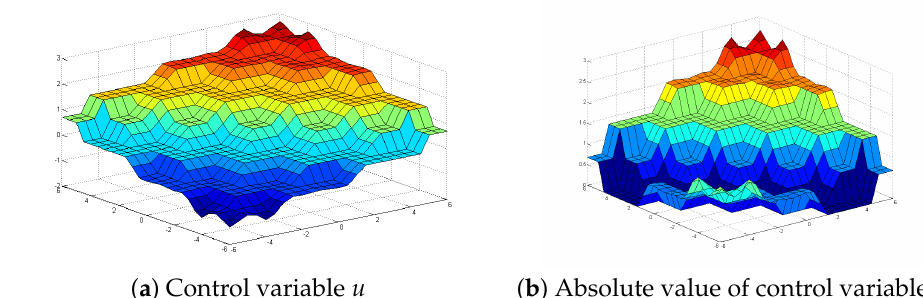
Figure 4. Inference results of the triple I algorithm based on Zadeh’s three-way fuzzy implication operator (or R 0 three-way residual